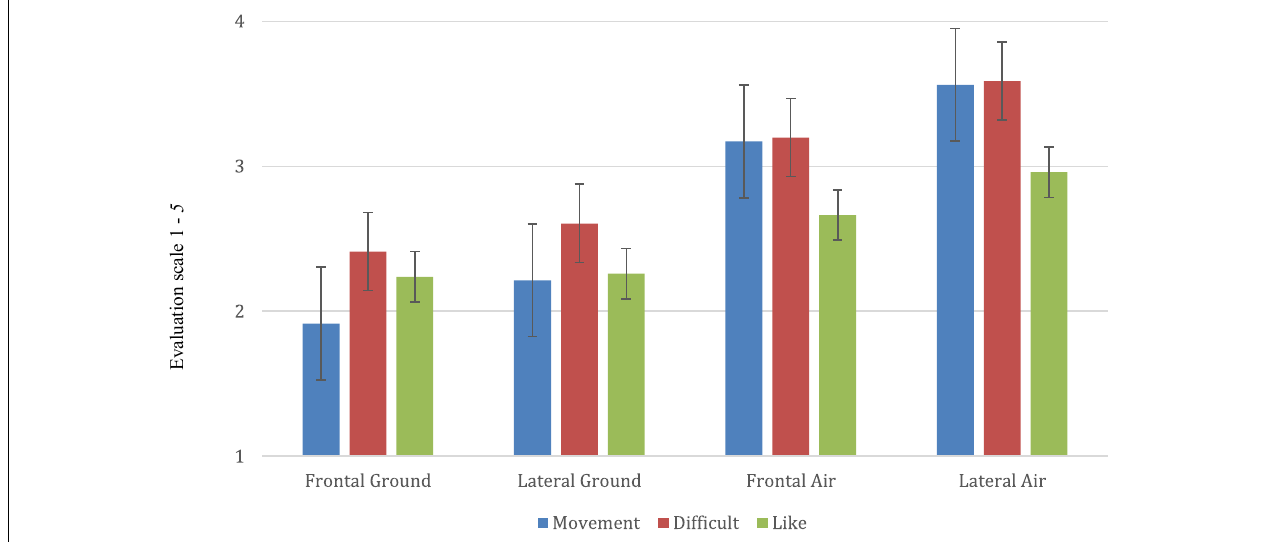
FIGURE 3 | Mean scores for the three variables, Movement , Difficulty and Liking for the four poses, F rontal On-ground , Lateral On-ground , Frontal In-air and Lateral in-air .